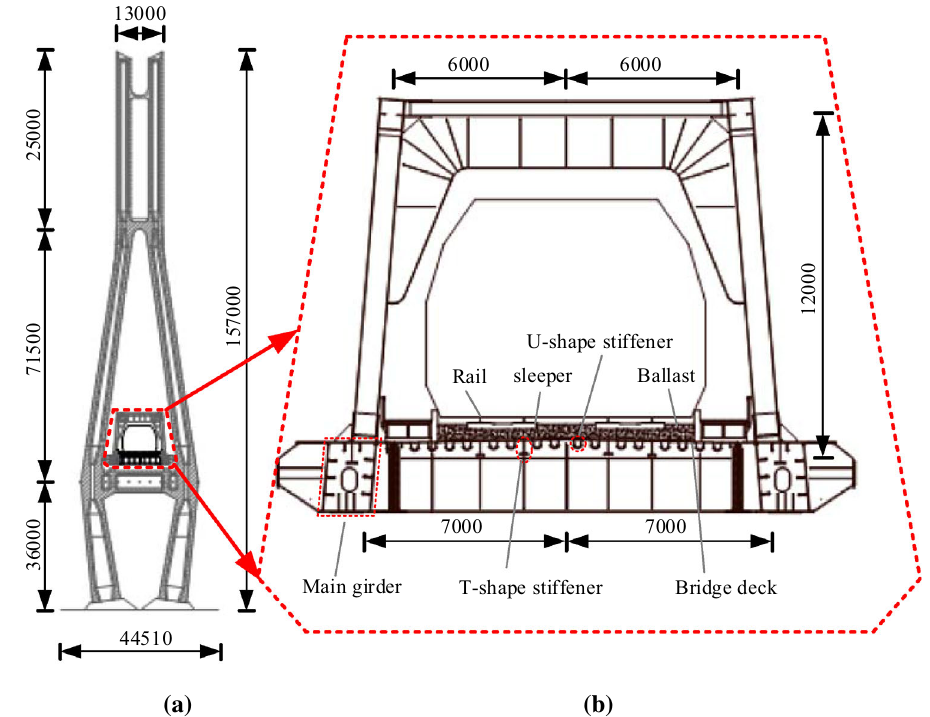
Fig. 5 Components of the cable-stayed bridge: a dimensions of the tower; b cross section of the stiffening beam (in mm)